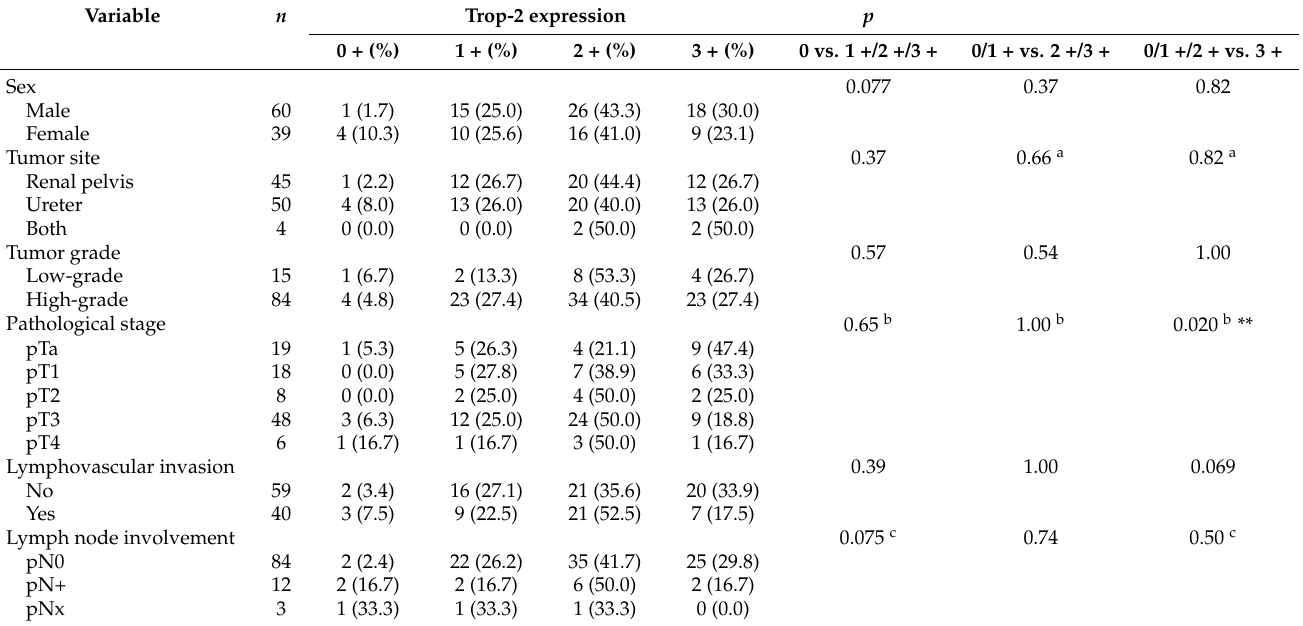
Table 2. Association of Trop-2 expression with clinicopathological characteristics of upper tract urothelial